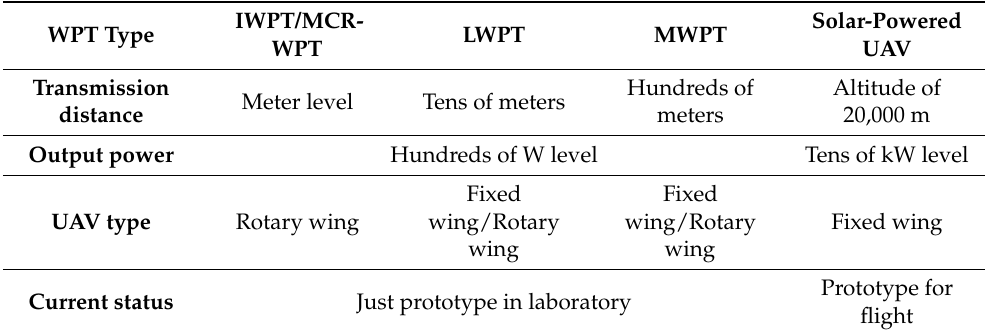
Table 4. Comparison of different types of WPT